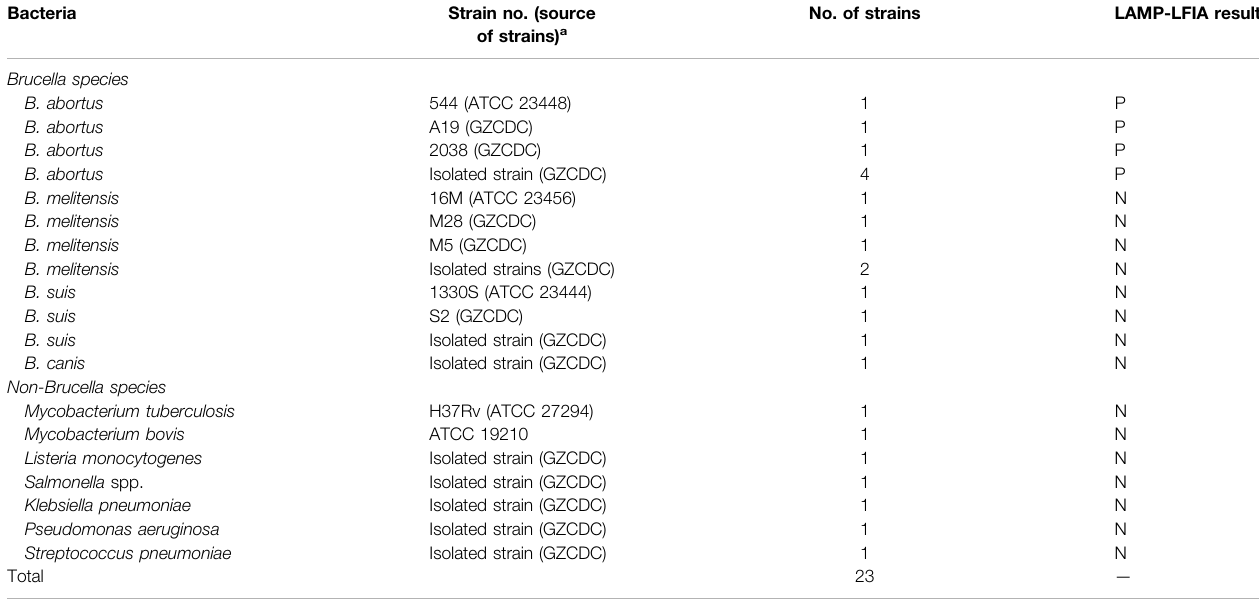
TABLE 2 | The information of bacterial strains in this study.